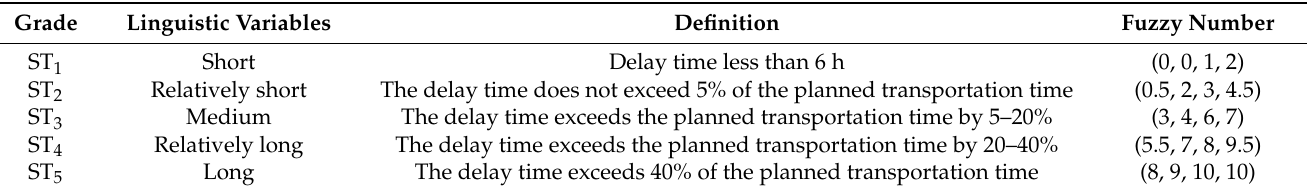
Table 5. Time delay ST fuzzy